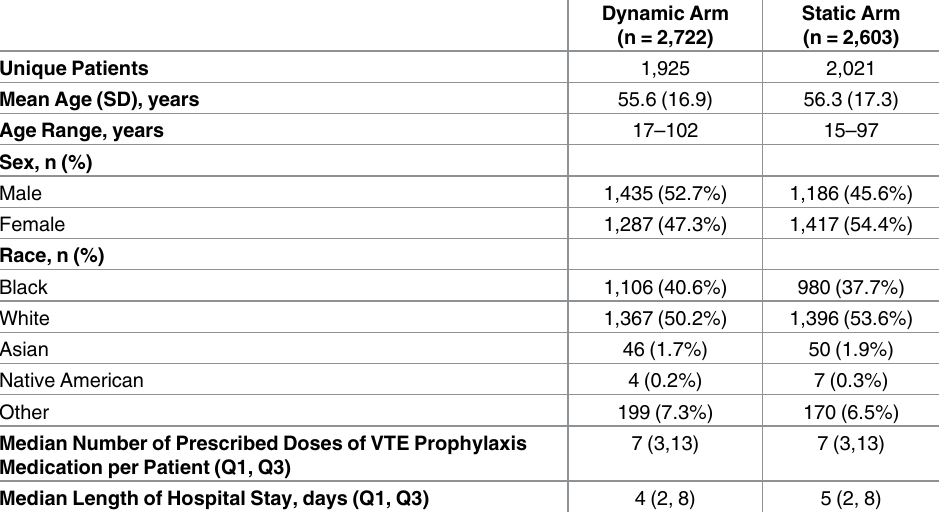
Table 1. Demographic characteristics of patient visits during the Baseline period, by